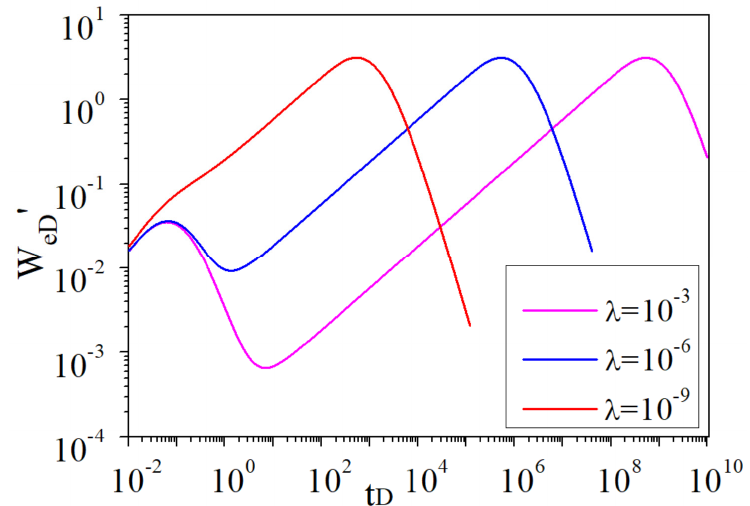
Figure 8. Dimensionless water influx curves of different λ .